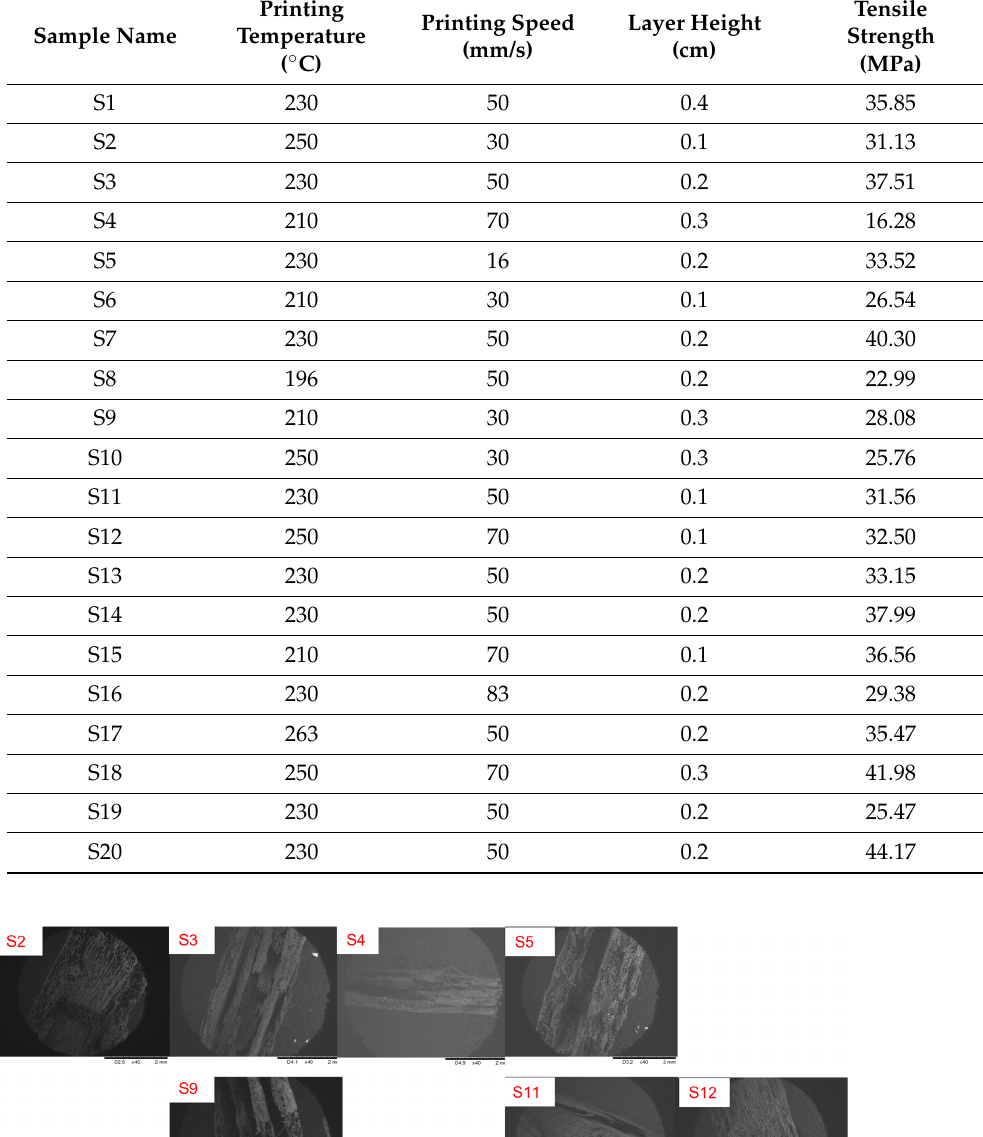
Table 1. Tensile strength results at different printing temperatures, printing speeds and layer heights for 20 wt.% polyamide reinforced carbon fibre. The parameters altered in the printing process were the printing temperature, printing speed and layer height.